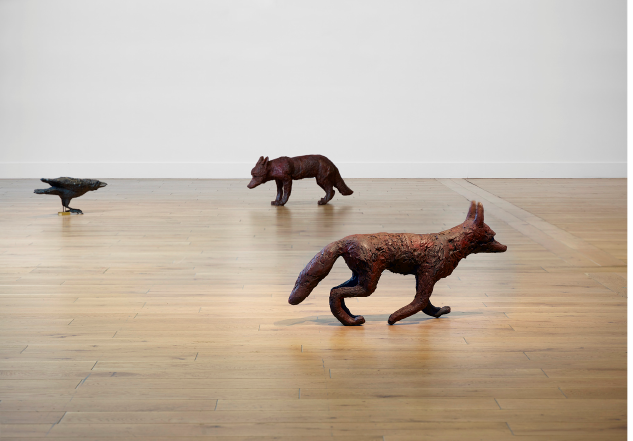
Figure 8. Foxes and crows (2022), Fieldnotes , HOME, Manchester. Ceramic, various sizes. Photograph by Michael Pollard.